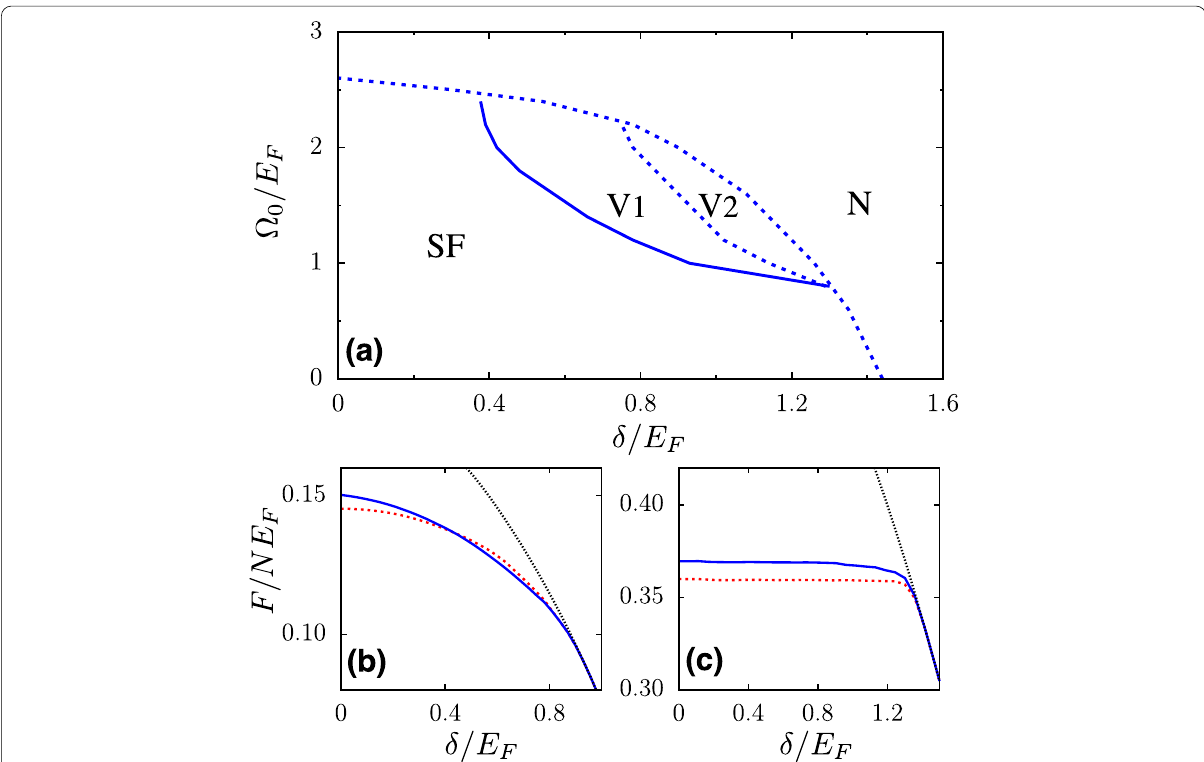
Fig. 9 a Phase diagram of a two‑dimensional Fermi superfluid with SOAM coupling in the (cid:31) 0 ‑ δ plane. The phase diagram includes the usual 0 , the normal state with (cid:31) 0 , and two vortex states with κ 1 : a fully gapped vortex states ( V 1) and a gapless vortex superfluid state with κ = = = − 0 ; red dashed), vortex ( κ 1 ; blue solid), and normal (black dotted) states as functions of δ , state ( V 2). b , c Free energies F of the superfluid ( κ = = − 2 ( b ) and � 0 / E 0.5 ( c ). Adapted from Ref. [66] with � 0 / E F F = =